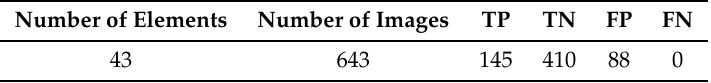
Table 8. Result of the evaluation (TP, TN, FP, and FN).